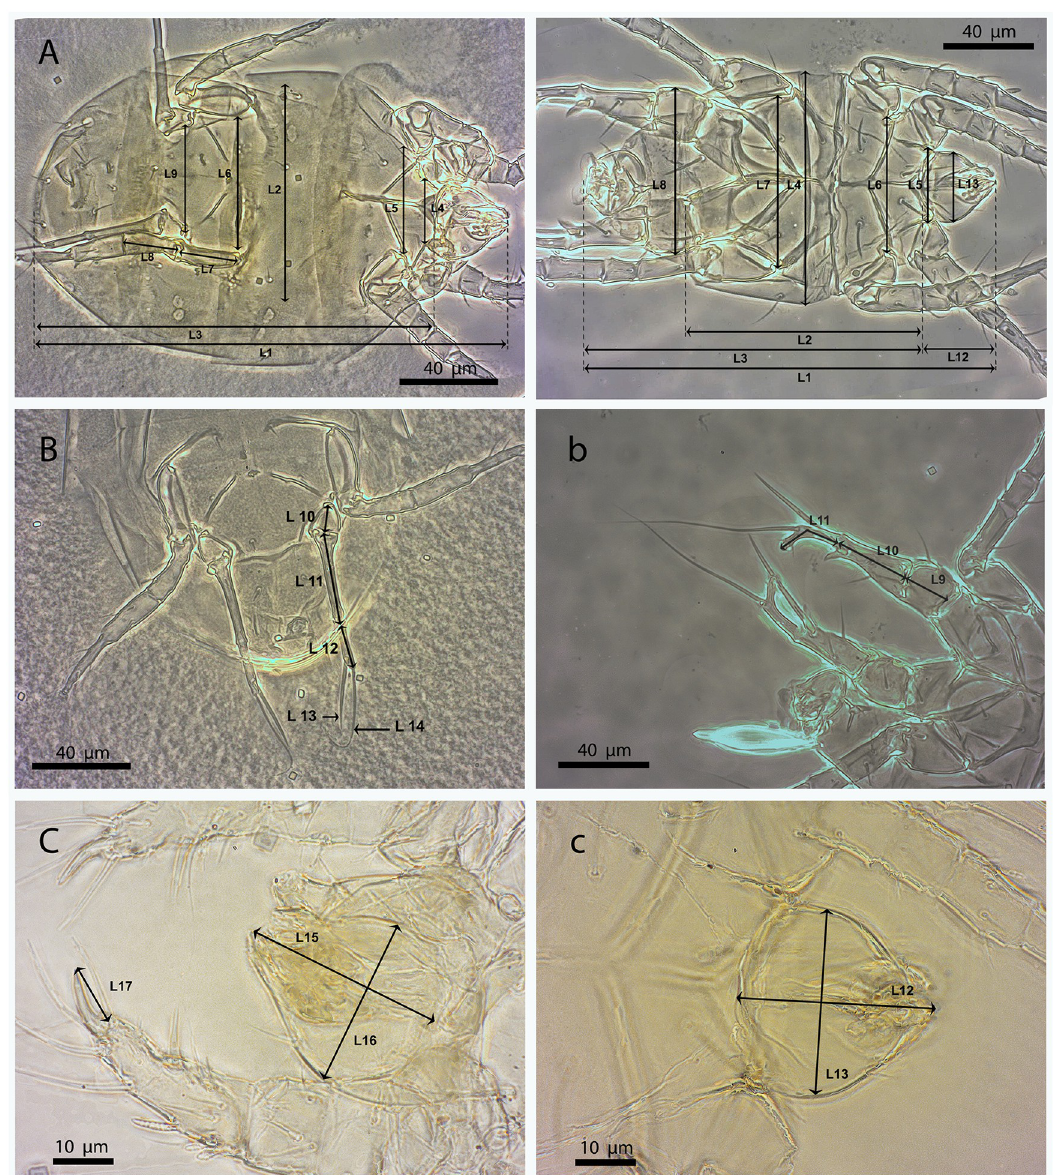
Fig 1. Biometric parameters evaluated in Polyphagotarsonemus latus (female and male). Females (A, B and C) and males (a, b and c). The key to the abbreviations can be found in Materials and methods (Morphological and biometric